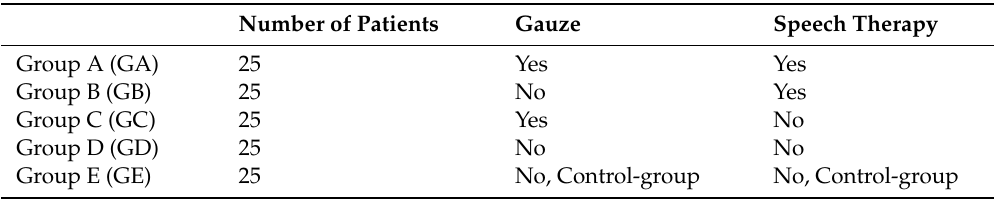
Table 2. Summary of data for each